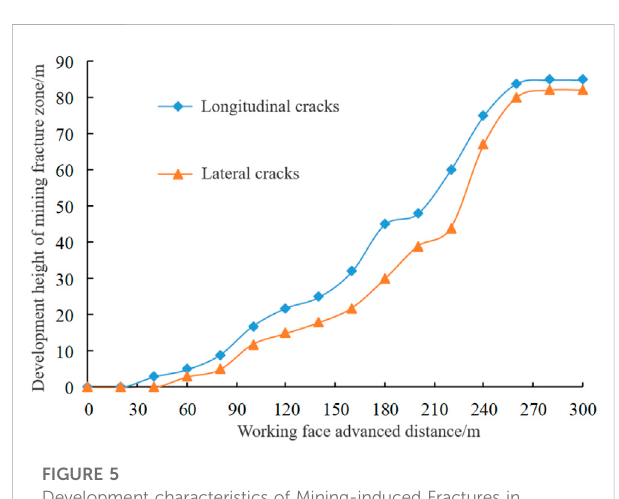
FIGURE 5 Development characteristics of Mining-induced Fractures in Na ’ er Coal